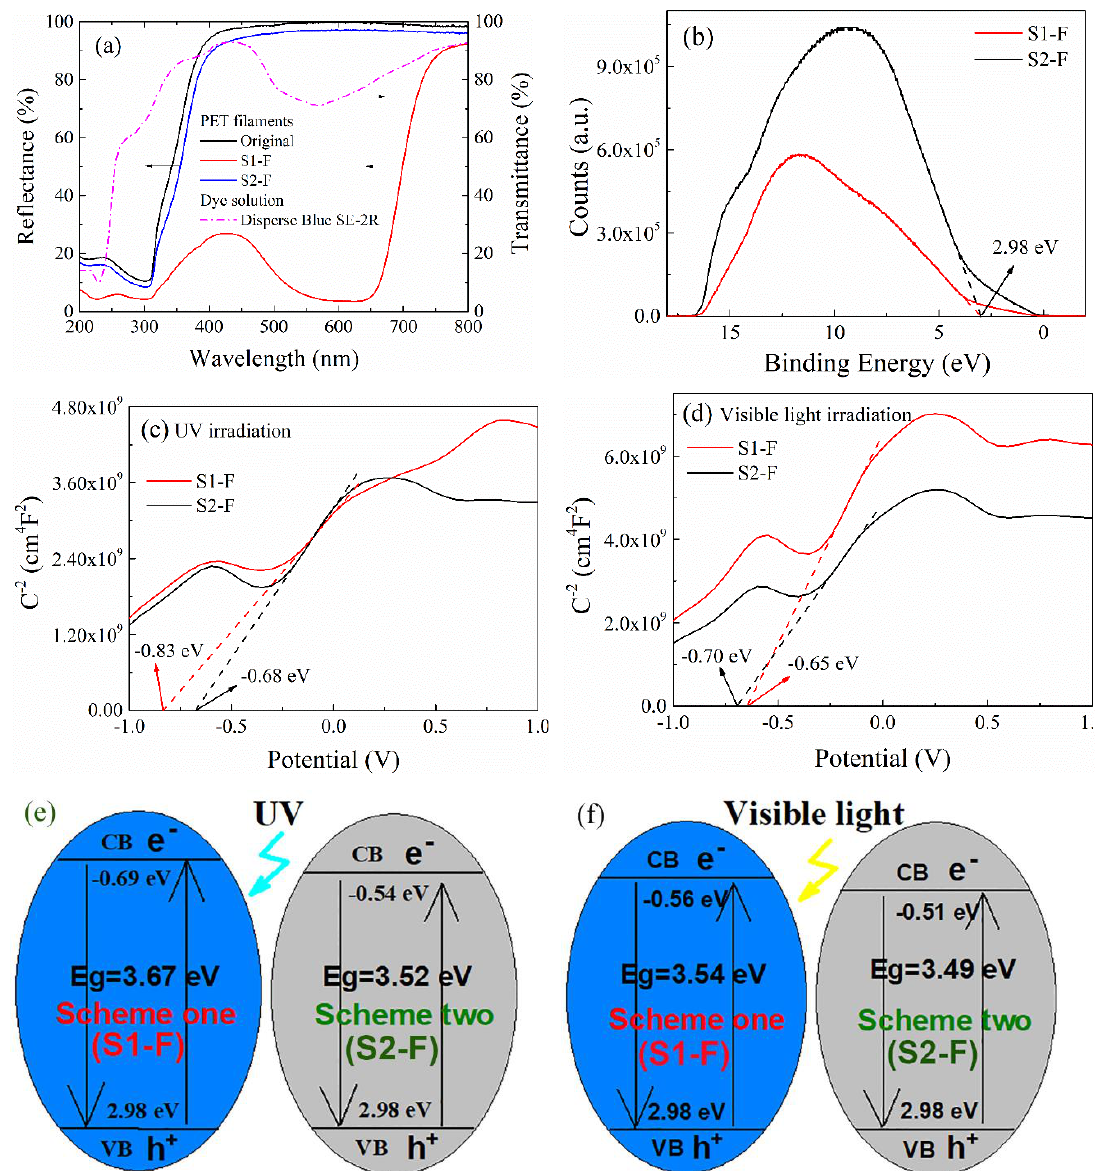
Figure 4. ( a ) Diffuse reflectance spectra, ( b ) UV photoelectron spectroscopy (UPS) spectra, M–S curves under ( c ) UV and ( d ) visible light irradiation, and band gaps ( e ) under UV and ( f ) visible light irradiation for the as-modified PET filaments.